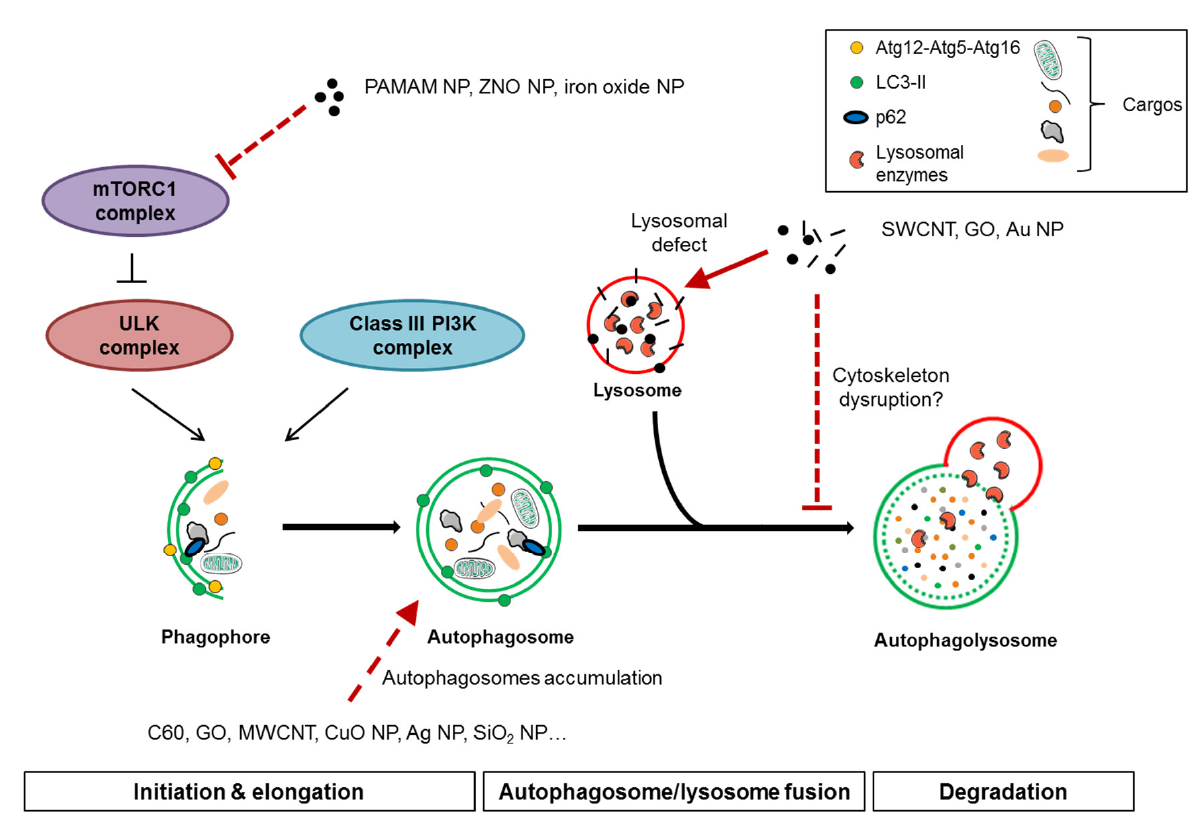
Figure 3. Nanomaterial-induced autophagy perturbation. Full lines relate to direct evidences of interaction of nanoparticles (NP) with the autophagic process whereas dotted lines relate indirect evidences of such